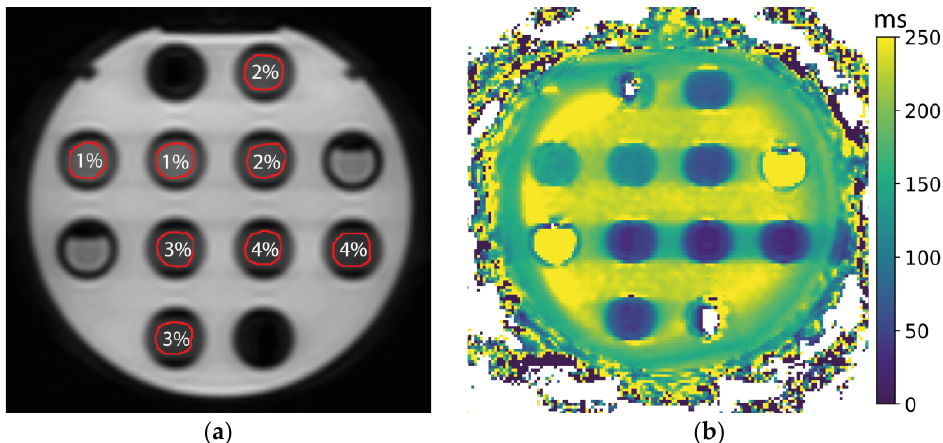
Figure 1. Example phantom measurement: ( a ) The phantom is shown as measured with a spin-lock time of 0 ms, and the percentages indicate the agar concentration in the tubes. The unmarked tubes contain distilled water; ( b ) T 1 ρ map of the phantom shown in ( a ).